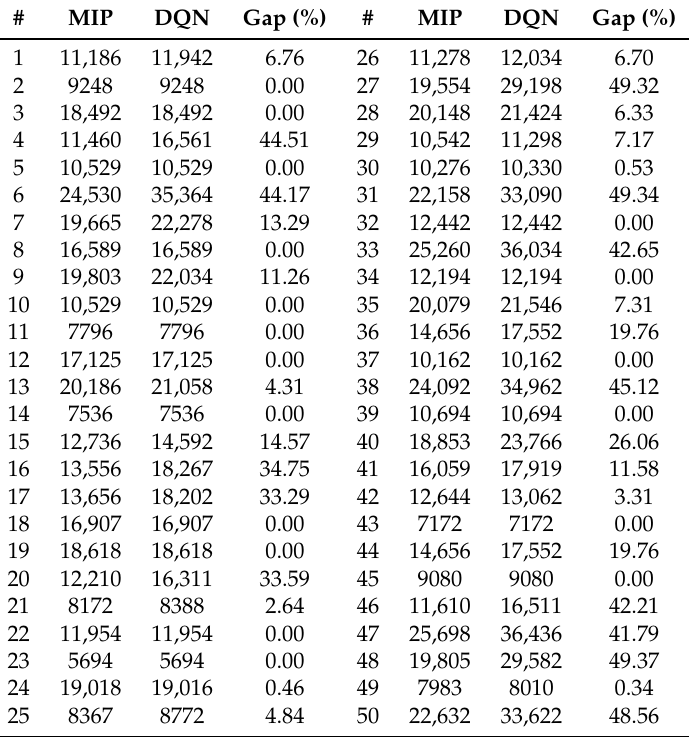
Table 4. Comparison on 50 4-train